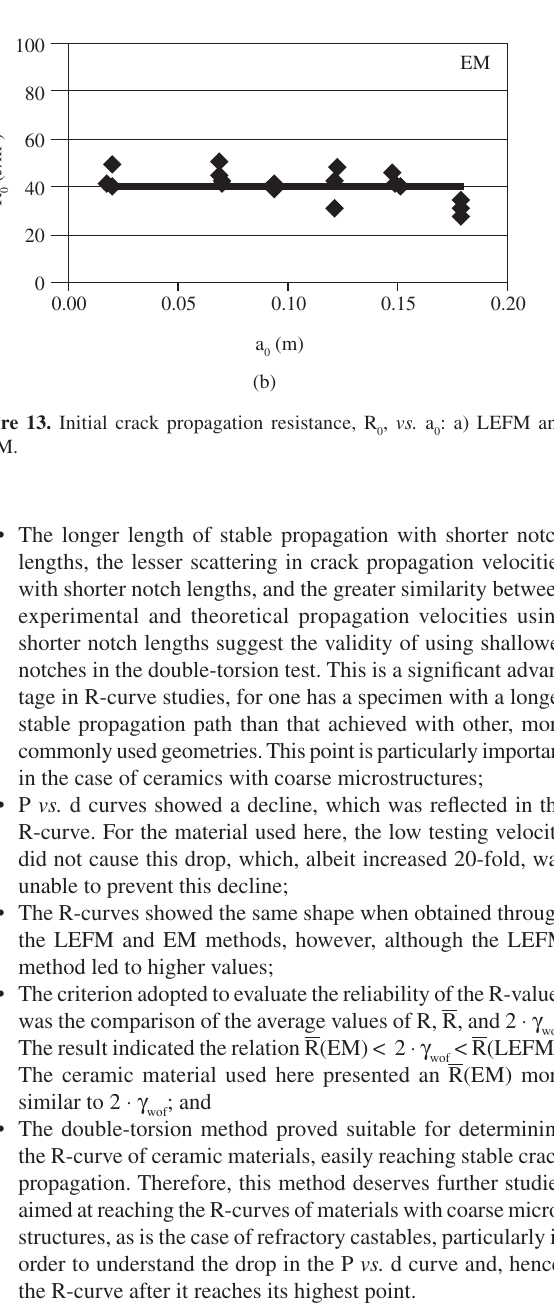
, vs. a : a) LEFM and 0 0